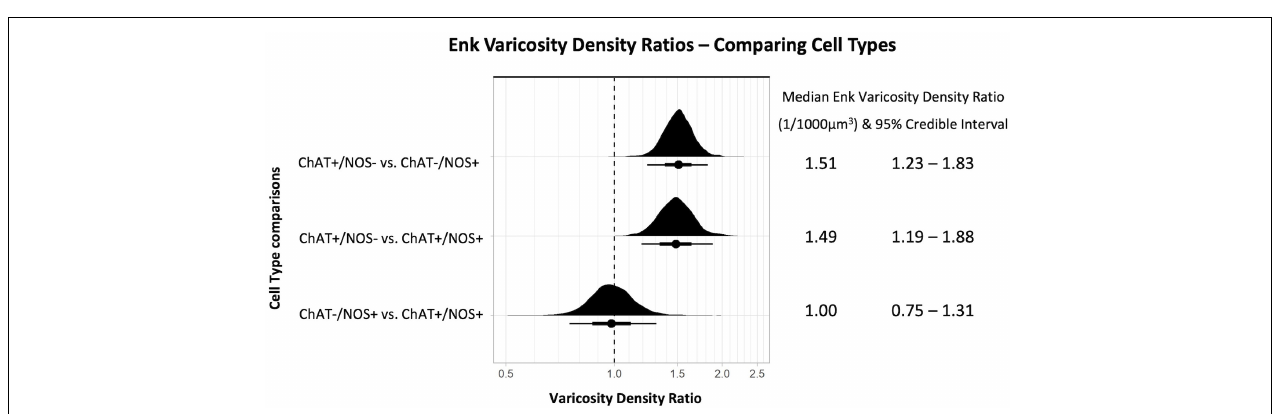
FIGURE 5 | Graph of the distribution of enkephalin varicosities close to cells. The upright curve in each graph is the distribution of the mean density for each cell type. Each small black dot beneath represents the density of ENK varicosities close to an individual cell. The posterior median of the mean varicosity density is greatest for the ChAT +/NOS– cell type, at 19.52 varicosities per 1,000 µ m 3 . The posterior median of the mean ENK varicosity density for each cell type is presented with the 95% credible intervals on the right. ChAT, choline acetyltransferase; NOS, nitric oxide synthase; ENK, enkephalin.